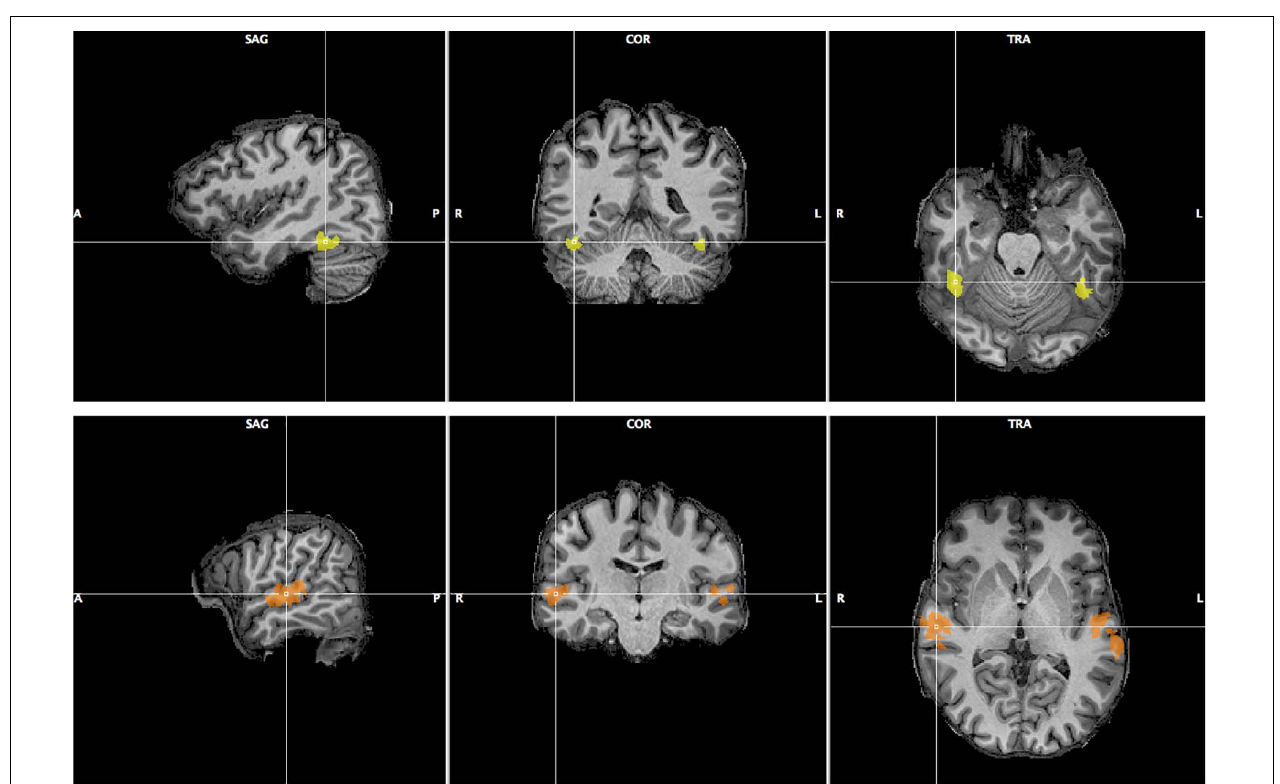
FIGURE 6 | Fusiform Face Area ( top row , yellow) and Temporal Voice Area ( bottom row , orange) as localized in one of the 12 participants of Experiment 2. Sagittal, coronal and transverse views are shown centered around the right FFA/TVA.